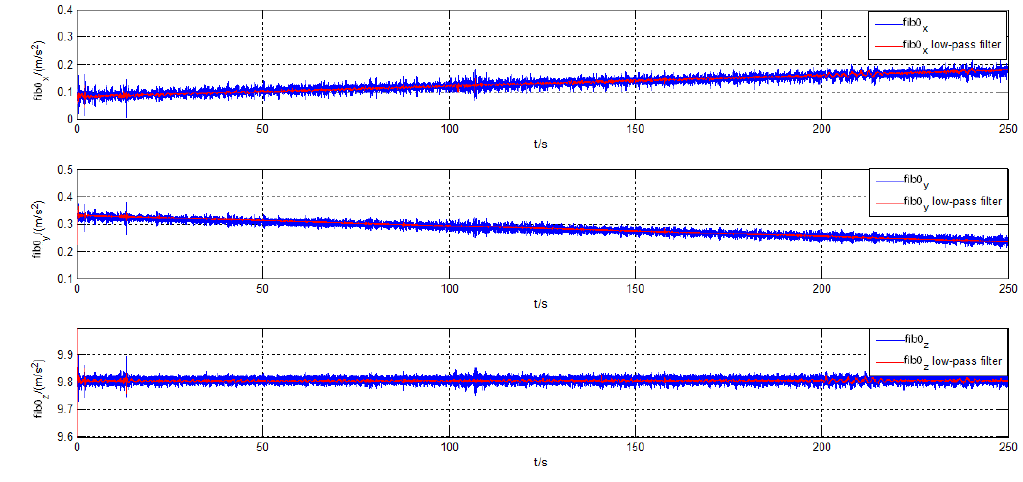
Figure 14. Denoising results of ˜ f i b 0 in the ship mooring experiment.